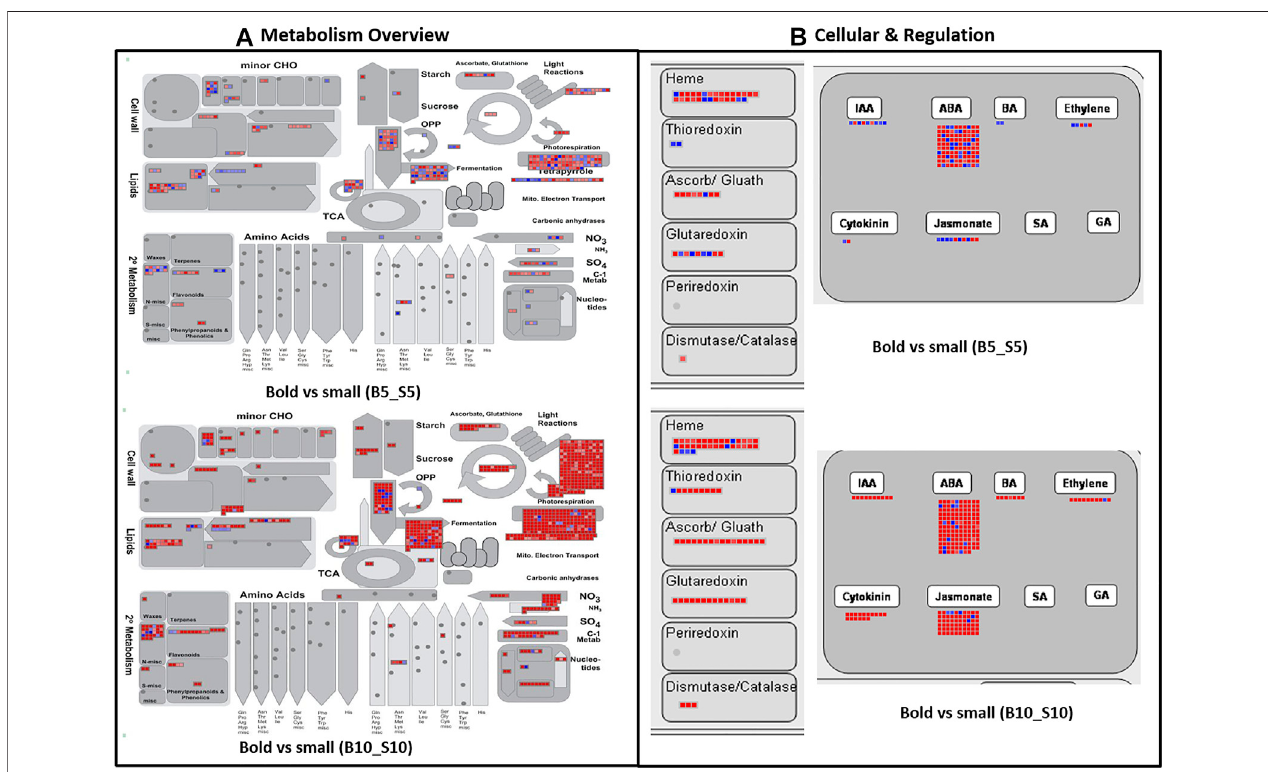
FIGURE6| MapMan pathway representingthedifferentialexpression ofgenesacrossthegenotypeinvolvedin (A) metabolism (B) cellular andregulationpathway in bold and small genotypes.